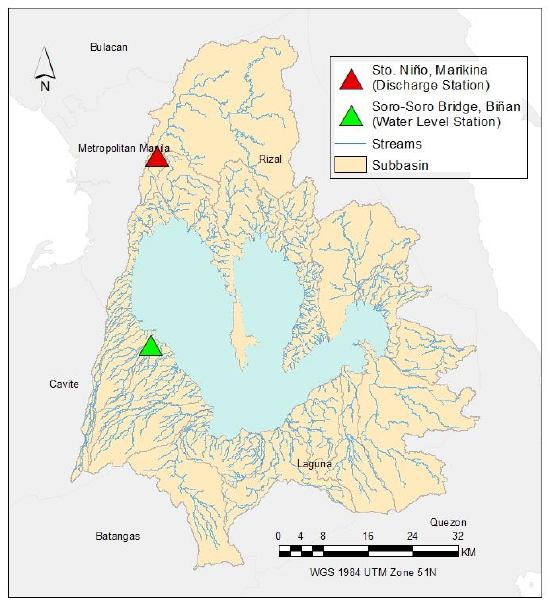
Figure 6 . Discharge stations used in the SWAT models.